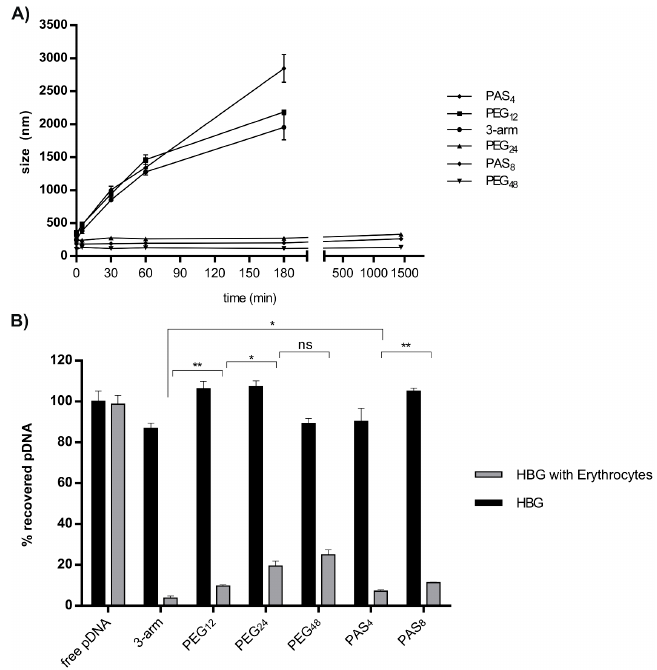
Figure 1. ( A ) Stability testing of untargeted polyplexes against phosphate-buffered saline (PBS). After 30 min of polyplex incubation (2 µ g pDNA; N/P 12) in deionized water and addition of 500 µ L PBS, DLS measurement was performed. Time points 0, 5, 30, 60, and 180 min were displayed. In case of colloidally-stable polyplexes of PEG 24 , PEG 48 , and PAS 8 , a measurement after 24 h is also displayed. Data are presented as mean value ( ± SD) out of triplets; ( B ) Polyplexes (2 µ g pDNA; N/P 12) were incubated in HBG with or without 3 × 10 6 erythrocytes. After centrifugation, the supernatant was taken, and 3500 IU of heparin were added to release pDNA of the polyplexes. Cy5 fluorescence was compared to uncomplexed (free) pDNA. Statistical analysis (Student’s t -test): ns p > 0.05, * p ≤ 0.05; ** p ≤ 0.01; *** p ≤ 0.001, **** p ≤ 0.0001.